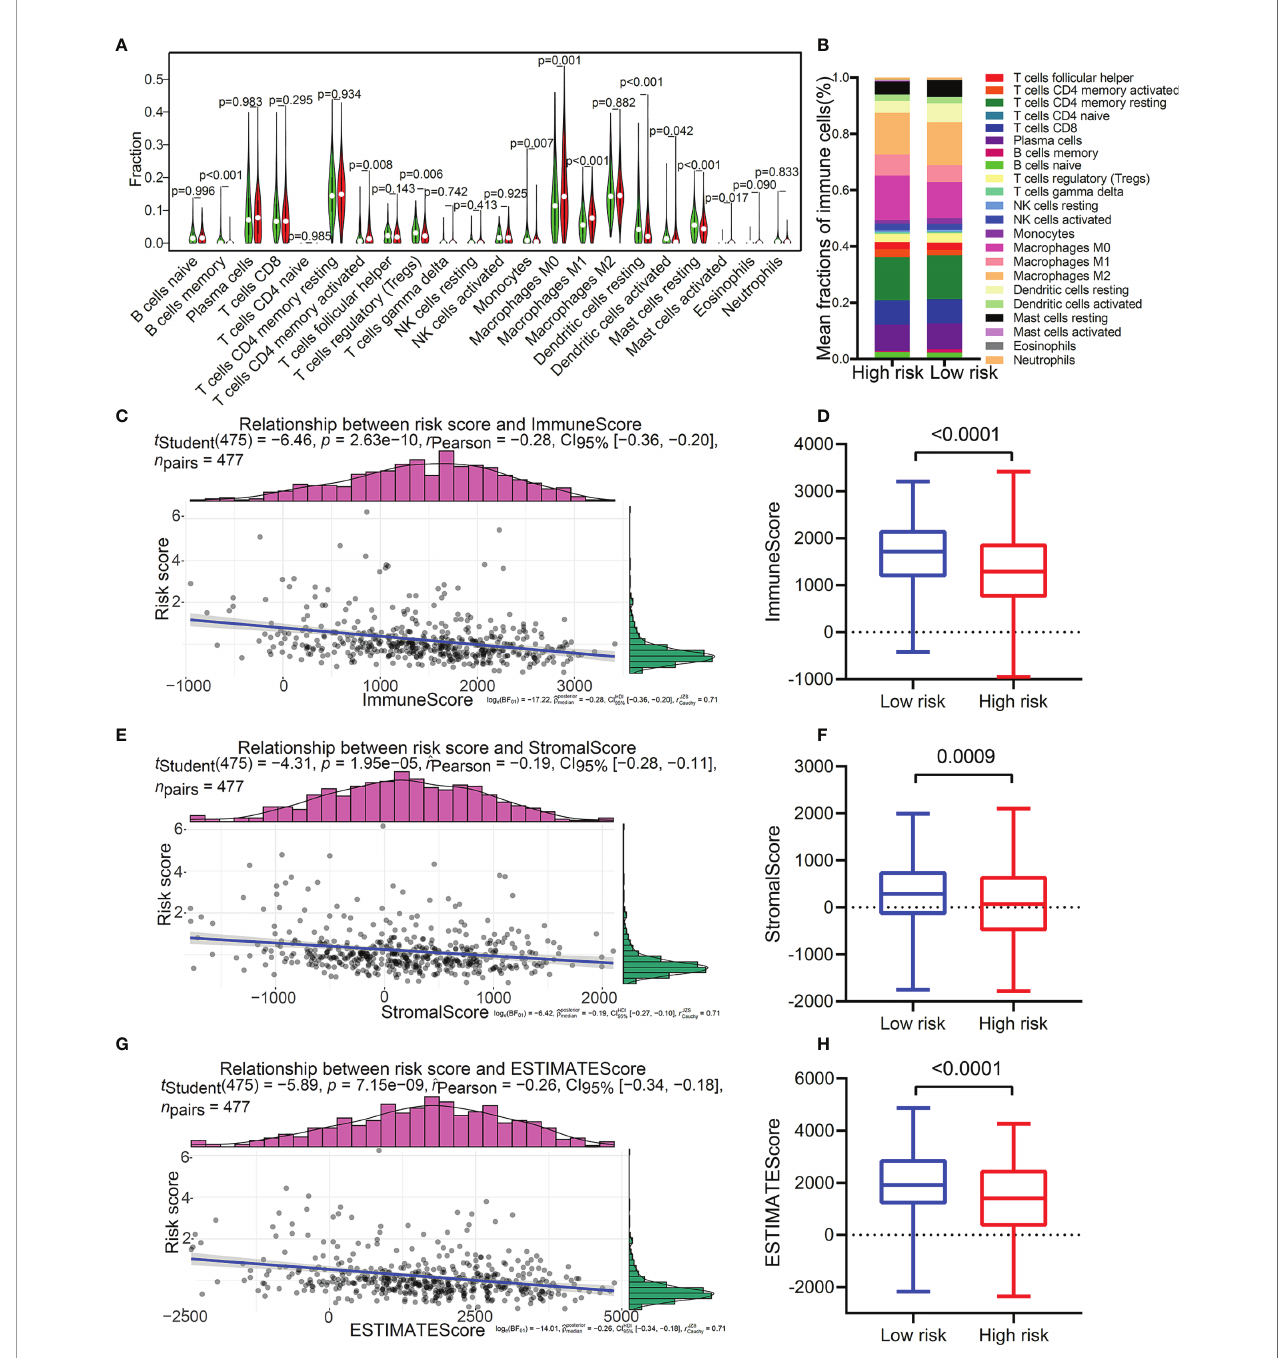
FIGURE 7 | Immune cell in fi ltration pro fi les in the two distinct risk patterns. (A) The comparison of the abundance of each in fi ltrating immune cell between high-risk group and low-risk group. (B) The distribution of each in fi ltrating immune cell in the two risk patterns. (C) The correlation analysis of risk score and immune score. (D) The comparison of immune score between high-risk group and low-risk group. (E) The correlation analysis of risk score and stromal score. (F) The comparison of stromal score between the two risk patterns. (G) The correlation analysis of risk score and ESTIMATE score. (H) The comparison of ESTIMATE score between the two risk